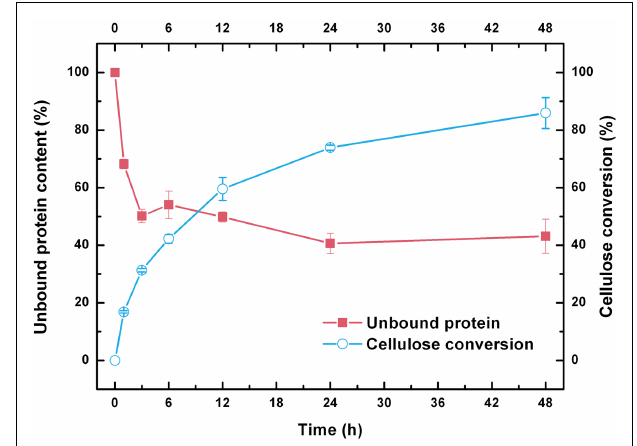
FIGURE 2 | Cellulase adsorption and cellulose conversion profiles during the hydrolysis of combined pretreated corncob